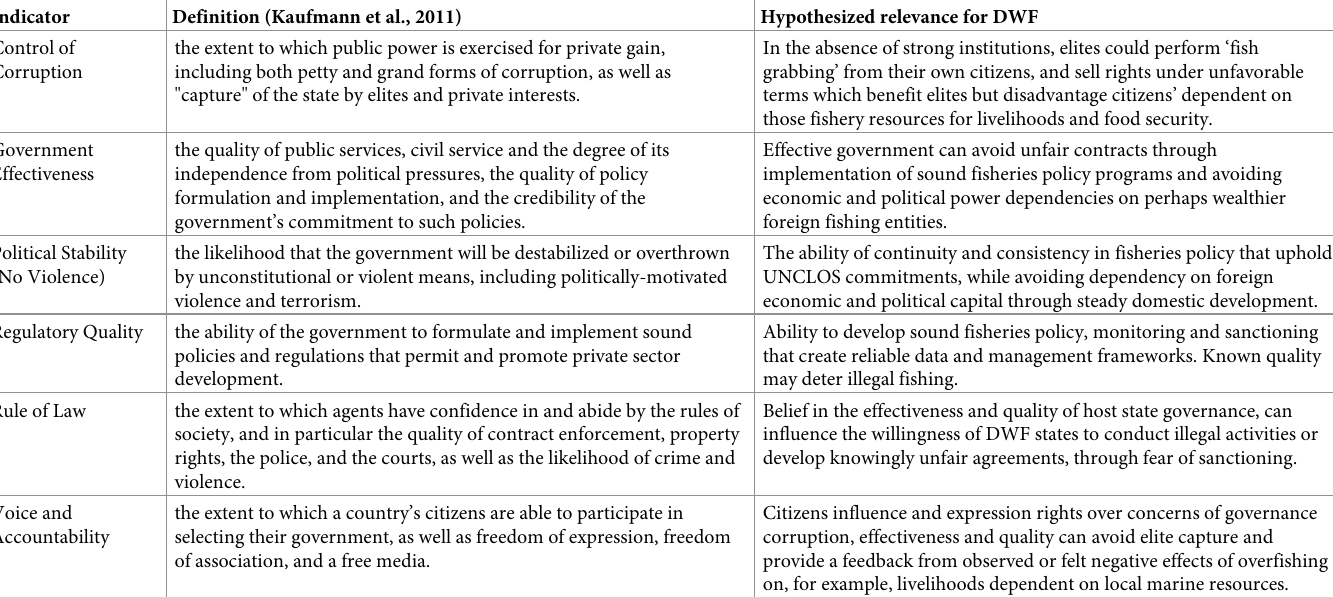
Table 1. World governance indicator definitions, and potential relevance for